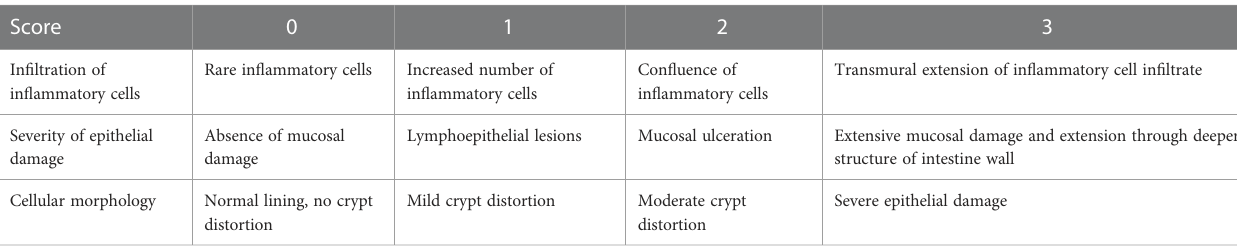
TABLE 1 Histological scoring table: parameters used to score in fl ammation on a scale from 0 to 3. Score 0 1 In fi ltration of in fl ammatory